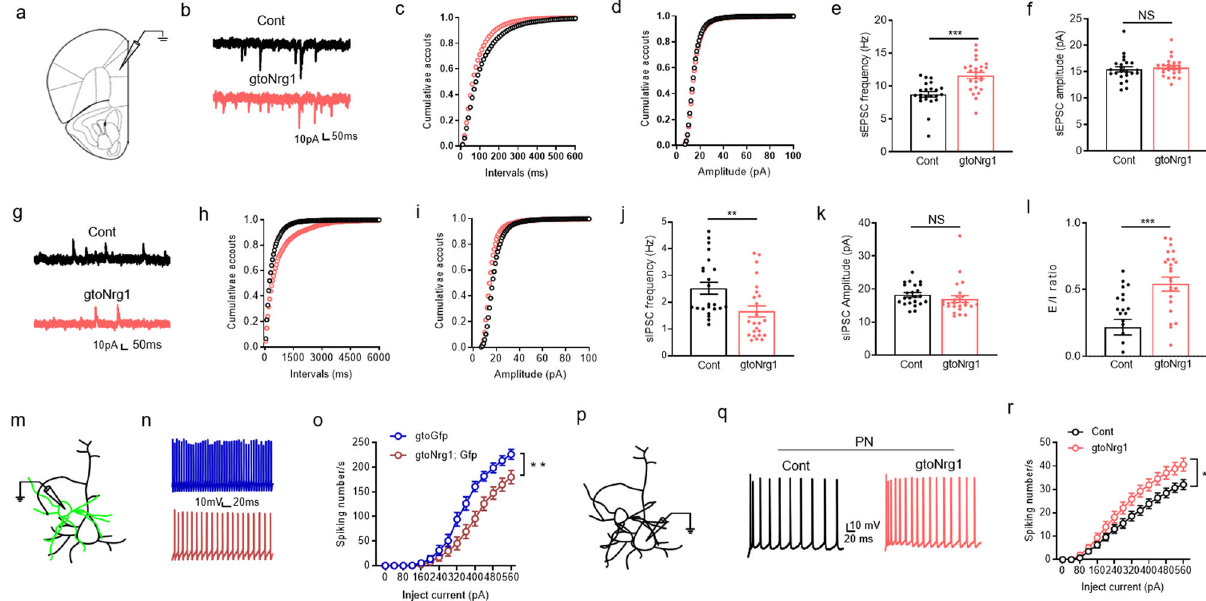
Fig. 4 Elevated E/I balance in the PFC of gto Nrg1 mice. a Diagram to show the whole-cell recording in layers 2 – 3 of PrL. b Representative traces of sEPSC from control and gto Nrg1 mice. c , d Cumulative plots of sEPSC frequency ( c ) and amplitude ( d ). e Increased sEPSC frequency in gto Nrg1 mice. *** P < 0.0001, two-sided t test, n = 23 cells from four control mice, n = 25 cells from four gto Nrg1 mice. Data are presented as mean values + / − SEM. f Similar sEPSC amplitude between control and gto Nrg1 mice. NS not signi fi cant, two-sided t test, n = 23 cells from four control mice, n = 25 cells from four gto Nrg1 mice. Data are presented as mean values + / − SEM. g Representative traces of sIPSC from control and gto Nrg1 mice. h , i Cumulative plots of sIPSC frequency ( h ) and amplitude ( i ). j Reduced sIPSC frequency in gto Nrg1 mice. ** P = 0.0068, two-sided t test, n = 23 cells from four control mice, n = 25 cells from four gto Nrg1 mice. Data are presented as mean values + / − SEM. k Similar sIPSC amplitude between control and gto Nrg1 mice. NS not signi fi cant, two-sided t test, n = 23 cells from four control mice, n = 25 cells from four gto Nrg1 mice. Data are presented as mean values + / − SEM. l Elevated E/I ratio in gto Nrg1 mice. *** P = 0.0002, two-sided t test, n = 23 cells from four control mice, n = 25 cells from four gto Nrg1 mice. Data are presented as mean values + / − SEM. m Diagram to show the recording of GABAergic interneurons expressing EGFP. n Representative action potentials of FS-GABAergic interneurons. o Reduced excitability of FS-GABAergic interneurons in gto Nrg1 ; Gfp mice, compared with gtoGfp mice. Shown are the I/O curves of action potentials from FS-GABAergic interneurons. **Genotype F (1, 36) = 8.813, P = 0.0053, two-way ANOVA, n = 17 cells from fi ve gtoGfp mice, n = 21 cells from four gto Nrg1 ; Gfp mice. Data are presented as mean values + / − SEM. p Diagram to show the recording of PN. q Representative action potentials of PN. r Increased excitability of PN in gto Nrg1 mice compared with controls. Shown are the I/O curves of action potentials from PN. *Genotype F (1, 50) = 5.041, P = 0.0292, two-way ANOVA, n = 27 cells from fi ve control mice, n = 25 cells from four gto Nrg1 mice. Data are presented as mean values + / −